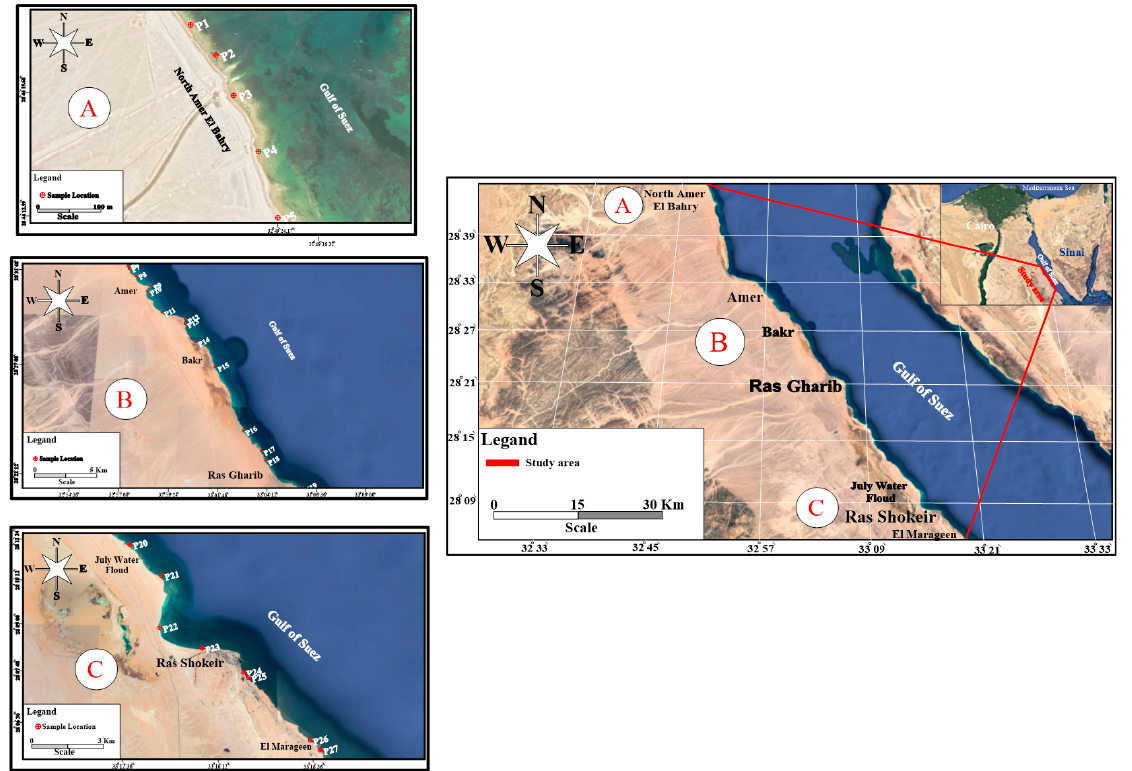
Figure 1. Map of the study area and measuring points.